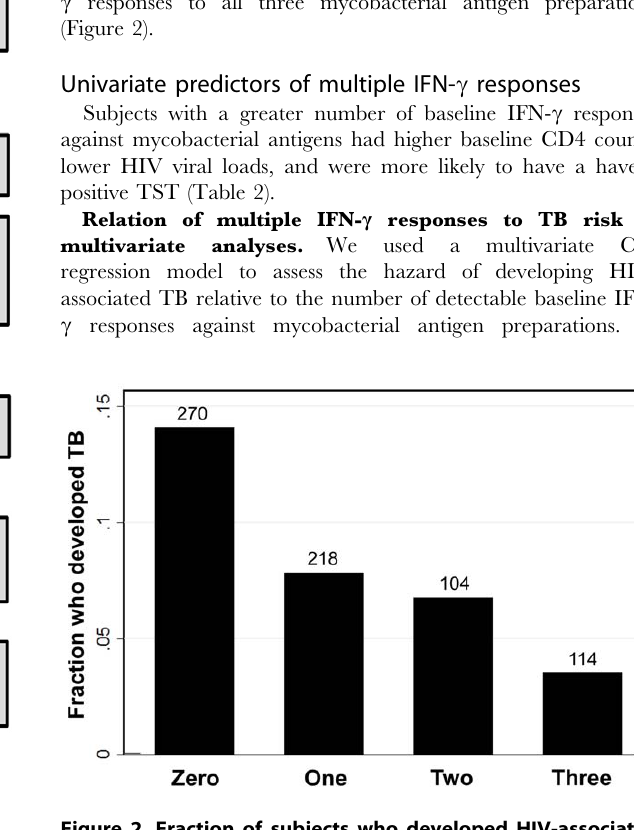
Figure 1. Study CONSORT diagram. ESAT-6, early secreted antigenic target 6; f/u, follow up; IFN, interferon gamma; PHA, phytohemagglutinin positive control; TB, tuberculosis.